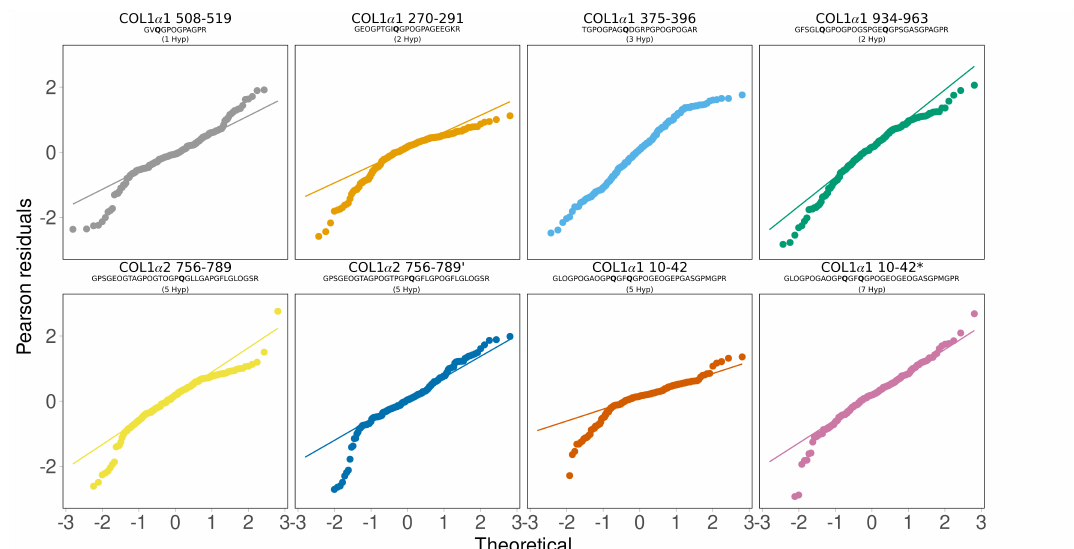
Figure 5. Normal quantile-quantile plots of Pearson residuals for the model fit for a) COL1 ↵ 1 508-519, b) COL1 ↵ 1 270-291, c) COL1 ↵ 1 375-396, d) COL1 ↵ 1 934-963, e) COL1 ↵ 2 756-789, f) COL1 ↵ 2 756-789’, g) COL1 ↵ 1 10-42 (5 Pro Hyp), and h) COL1 ↵ 1 10-42* (7 Pro Hyp). Except a few deviations from the inserted 1-1 lines, ! ! in particularly at the tails for some of the peptides, the quantile-quantile plots indicates normality of the residuals as proposed by the PQI model. 200 randomly selected data points are shown in each plot.